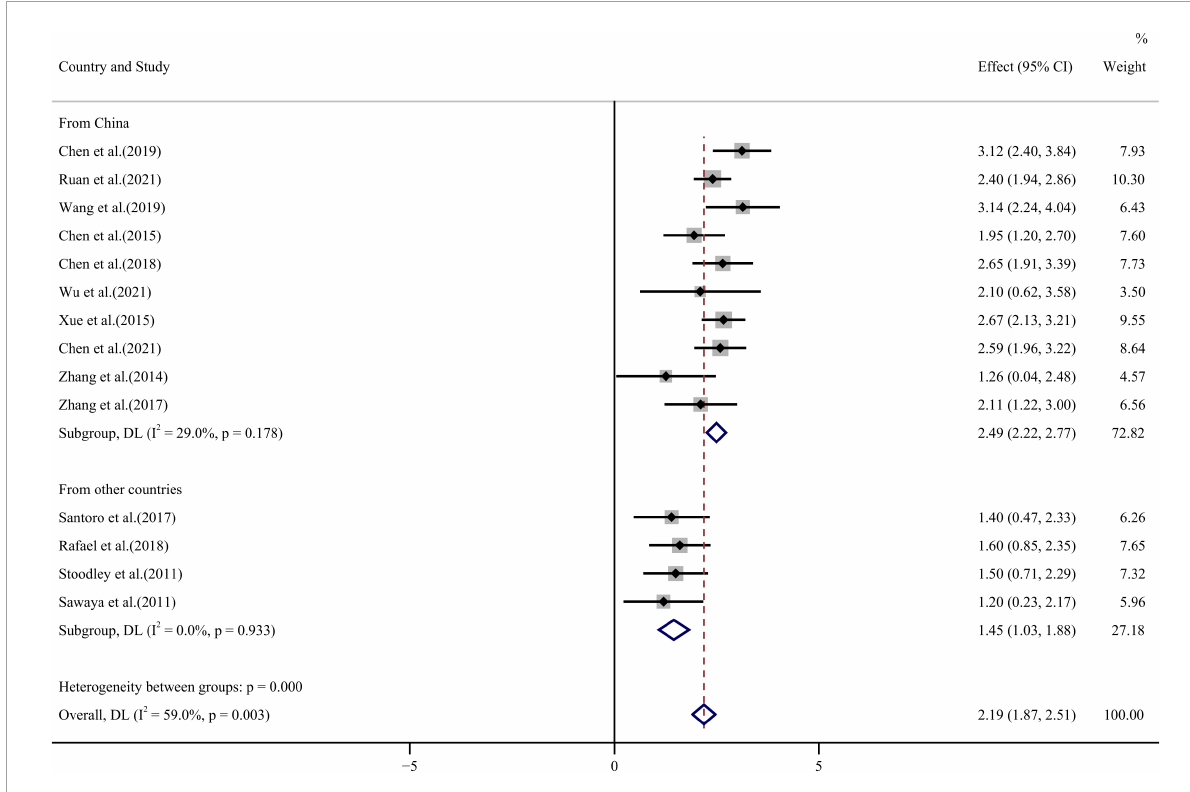
FIGURE5 GLS forest plot [Forest plot of weighted mean difference (WMD) of the association between GLS absolute value reduction and anthracyclines therapy].